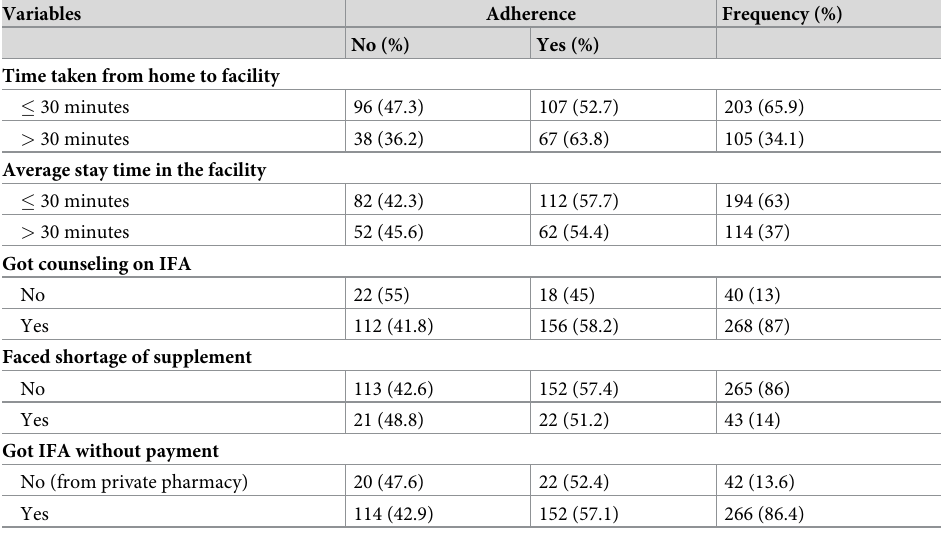
Table 3. Health facility related characteristics of pregnant women attending antenatal care in public health facili- ties at Dire Dawa, Eastern Ethiopia. n =